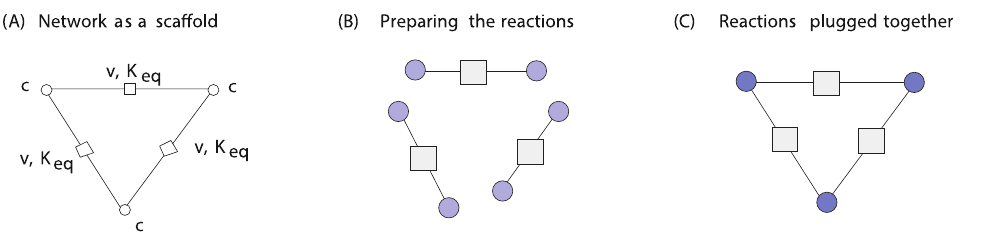
Figure 2. Consistent parameter sets for large kinetic models. (A) The metabolic network provides a frame for formulating parameter dependencies. Stationary fluxes v , concentrations c , and equilibrium constants K eq must be thermodynamically consistent. (B) For each reaction, the Michaelis constants k M and k cat need to agree with the predefined quantities c , K eq , and v . (C) Given a consistent parameter set, enzymatic reactions can be safely connected. The resulting model will actualise a predefined steady state, with rate laws satisfying the following conditions: (i) Quantities shared by several reactions – for instance, metabolite concentrations – have the same values in each of them. (ii) For internal metabolites, incoming and outgoing fluxes are balanced. (iii) Quantities that arise from differences along reactions satisfy the Wegscheider conditions: for instance, their sums over closed loops vanish. (iv) The kinetic constants satisfy the Haldane relationships, which relate the kinetic constants of a rate law to the equilibrium constant of the reaction. (v) Flux directions agree with thermodynamic forces, given by the negative differences { D r m of chemical potentials.